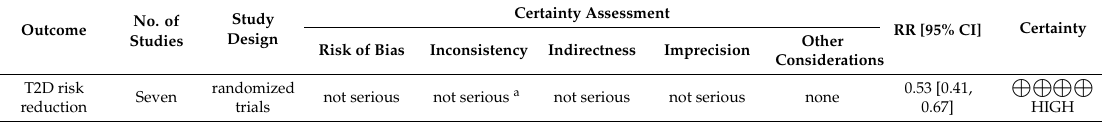
Table 3. GRADE assessment for the e ff ect of lifestyle changes on T2D